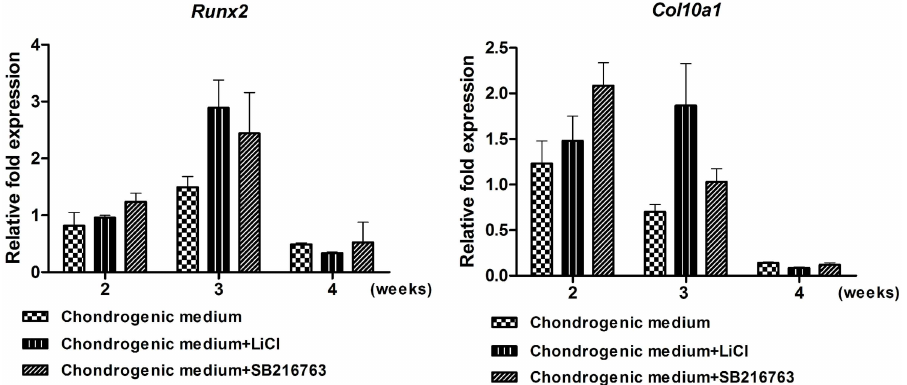
Fig 8. Expression level of hypertrophic markergenes (A) Col10a1 , and (B) Runx2 was quantified by qPCR after 2, 3, and 4 weeks of inductions. Gene expressionwas normalized to coresponding GAPDH and calculatedby relative expressioncomparedto control cells. Data were expressedas mean ± SD,The expperiments were perfromed three